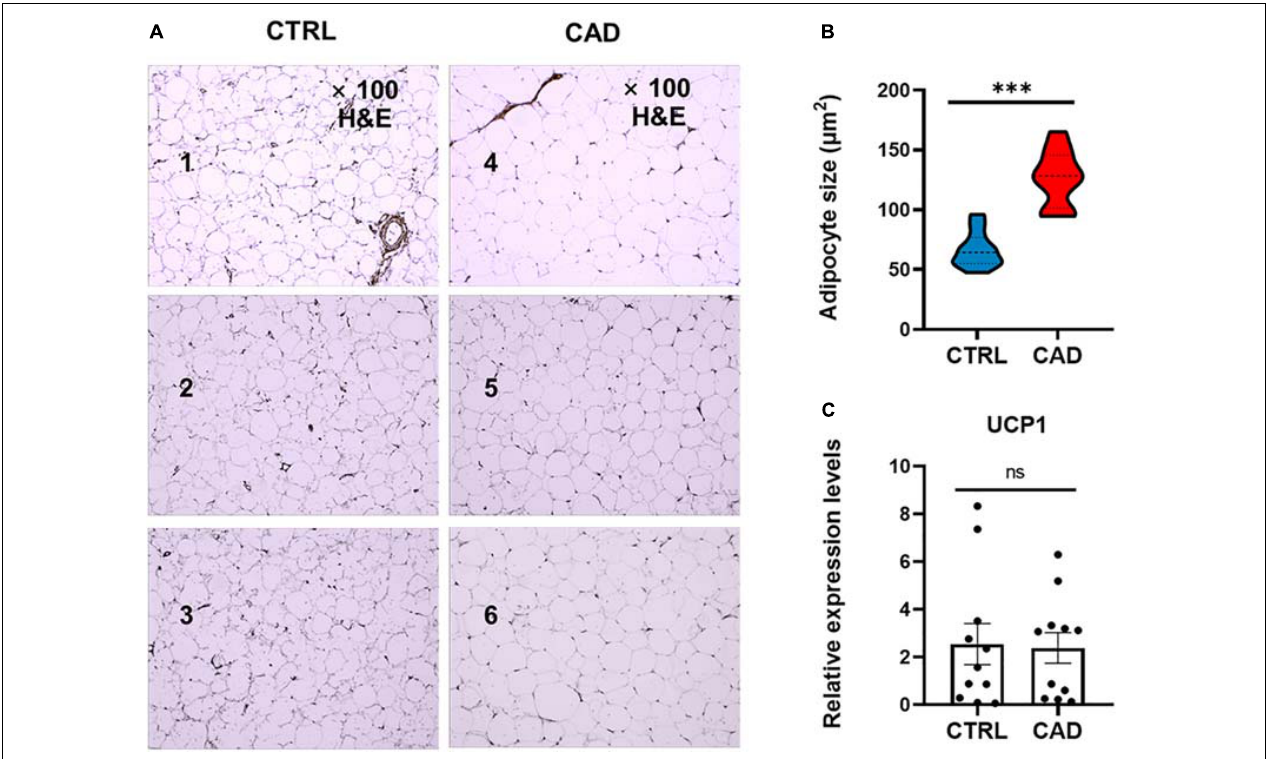
FIGURE 1 | Comparison of EAT in histology. (A) H&E staining of epicardial adipose tissue (EAT) in the control and coronary artery disease (CAD) groups (100 × magnification). Numbers 1–3 were EAT samples of three control subjects, while numbers 4–6 were EAT samples of three CAD patients. (B) The mean adipocyte size was larger in CAD group (*** p < 0.001). (C) Expression levels of uncoupling protein 1 (UCP1) in the CTRL and CAD group (ns, p >